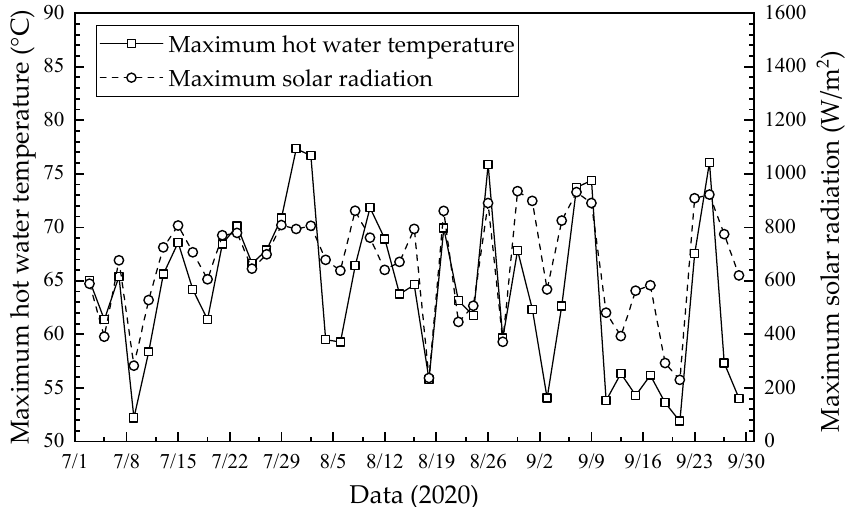
Figure 8. Daily maximum hot water temperature and solar radiation from July to September 2020.